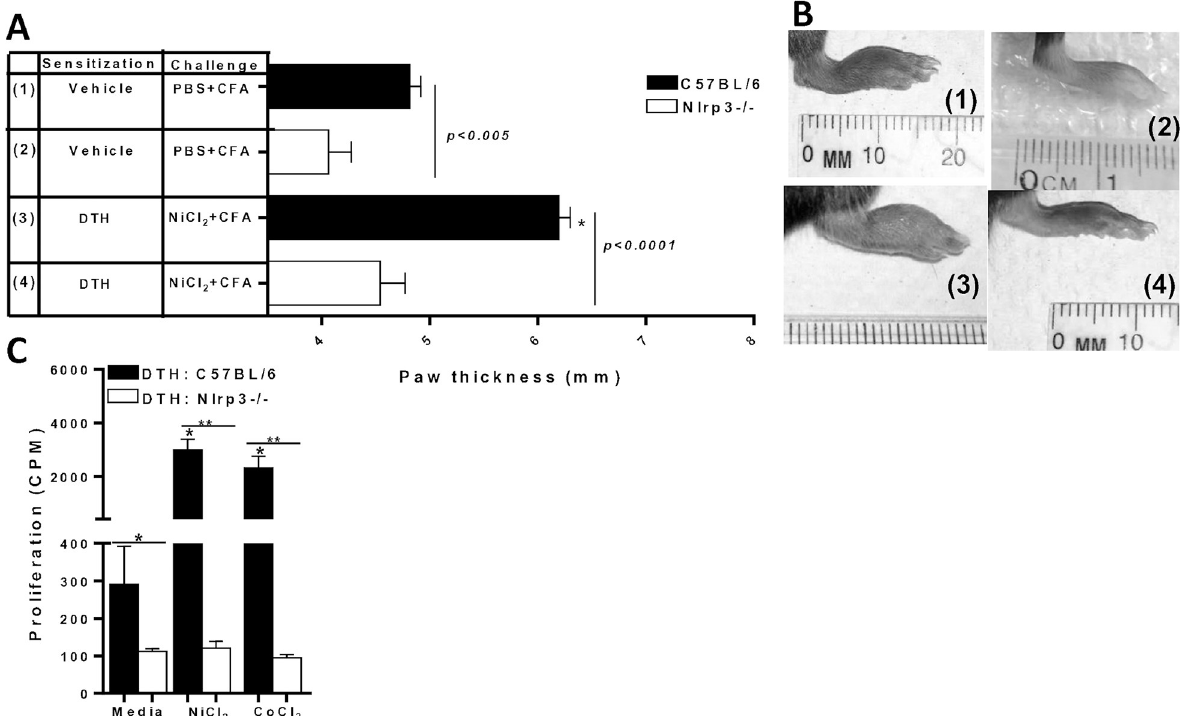
Fig 3. Nlrp3-/- mice do not exhibit metal-DTH reactivity in vivo or in vitro . (A) DTH was determined by measuring paw thickness 48 h after challenge (D 14) in mice that were sensitized and challenged as indicated on D 12 and (B) corresponding representative photographs (correspond to label group numbers 1–4) of inflammatory lesions in the paw of vehicle- and metal-DTH treated C57BL/6 (black bars) or Nlrp3-/- (white bars) mice. At D 14, spleens were harvested co-cultured with or without Ni (0.001mM) or Co (0.001mM) challenge for four days. (C) Proliferation of splenocytes was measured by 3 H-thymidine incorporation. Data represent one of three independent experiments with 3–4 mice/group in each experiment. Data are shown as mean ± SEM. Statistical significance was determined by Student’s unpaired two-tailed t-test ( � P � 0.05, �� P � 0.001).